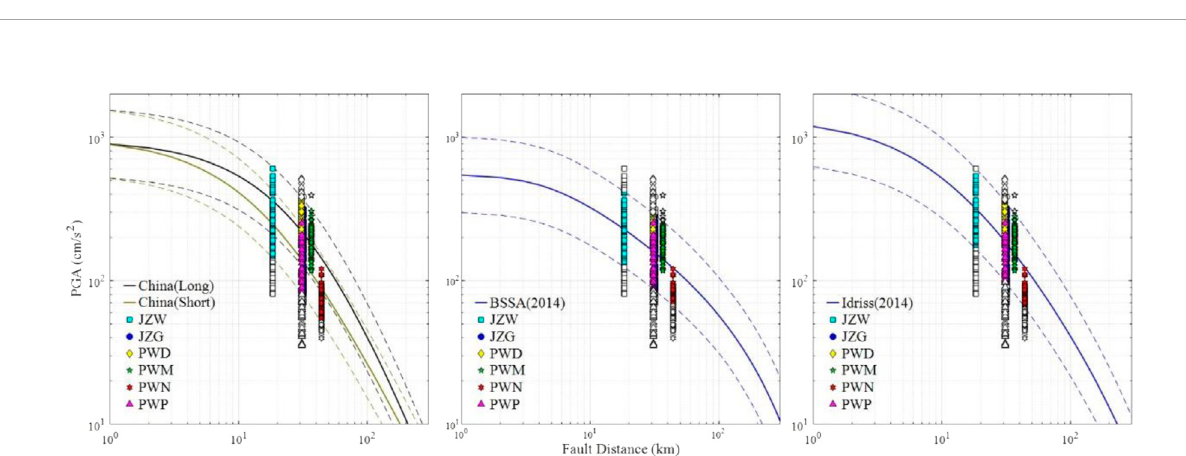
FIGURE 7 Acceleration time history of 6 calculation points selected by the three attenuation relationships.